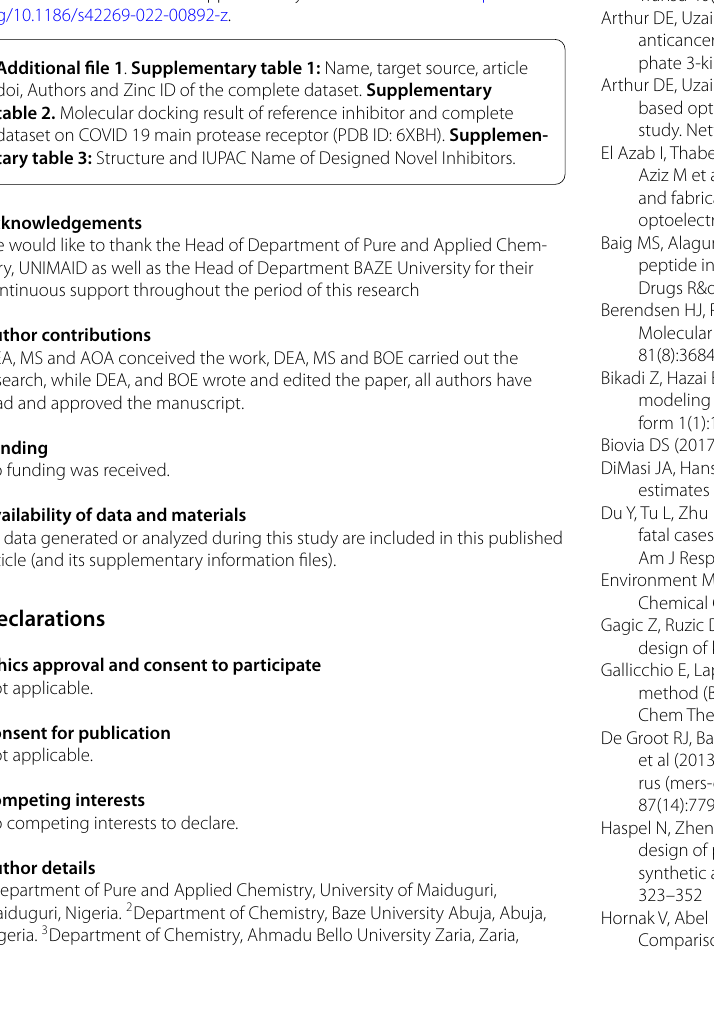
table 2. Molecular docking result of reference inhibitor and complete dataset on COVID 19 main protease receptor (PDB ID: 6XBH). Supplemen- tary table 3: Structure and IUPAC Name of Designed Novel